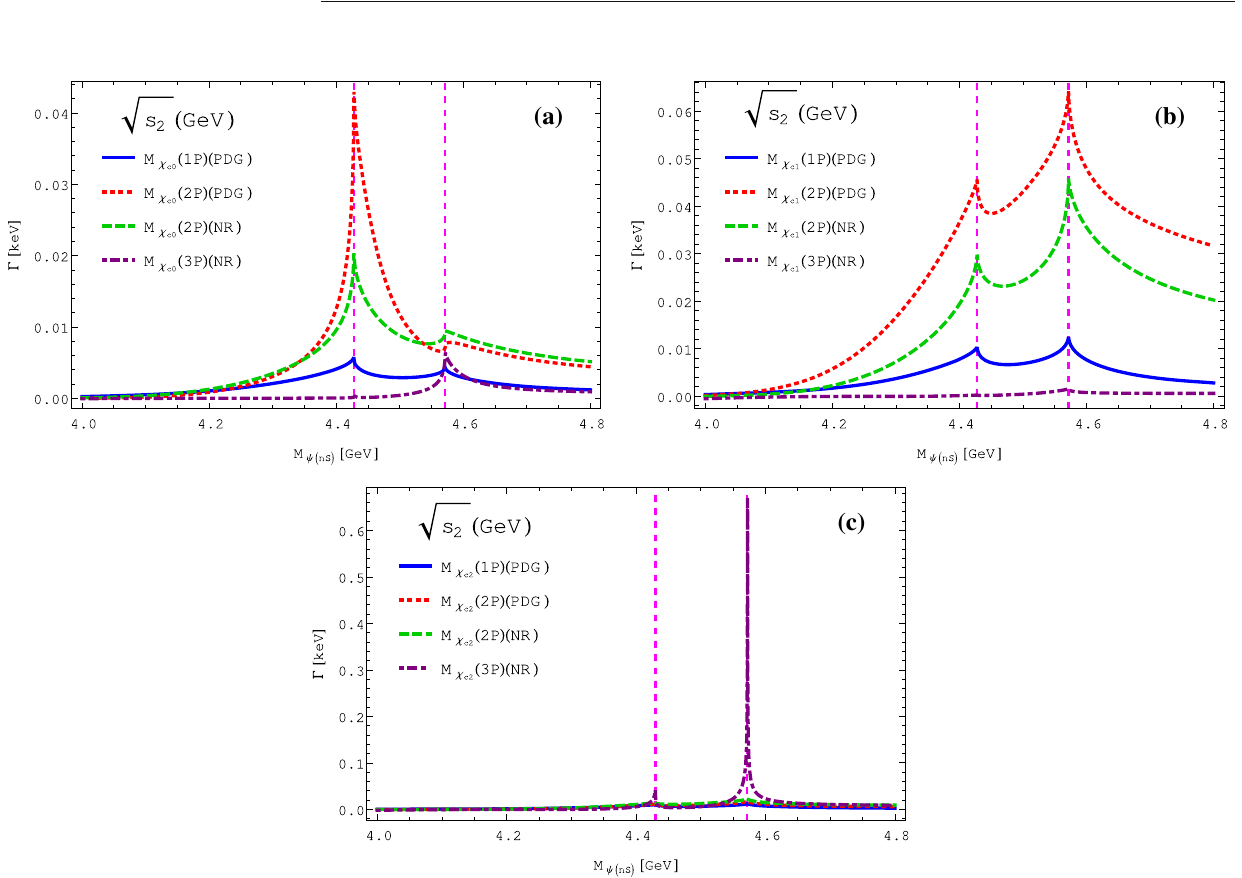
Fig. 2 M ψ( nS ) -dependence of the rescattering amplitude squared | M | 2 of ψ( nS ) → γχ cJ ( mP ) . The vertical dash lines indicate a and b : (from + ( 2460 ) D − ( 2460 ) D ∗− left to right) D + s and D s threshold, respectively; c D s 1 s 1